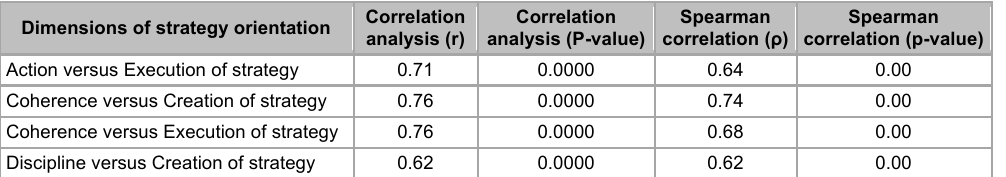
A summary of the correlation analysis (r) and p-values as well as the Spearman correlation coefficient comparing the dimensions of strategy orientation with the constructs of strategic leadership (N= 118) Dimensions of strategy orientation